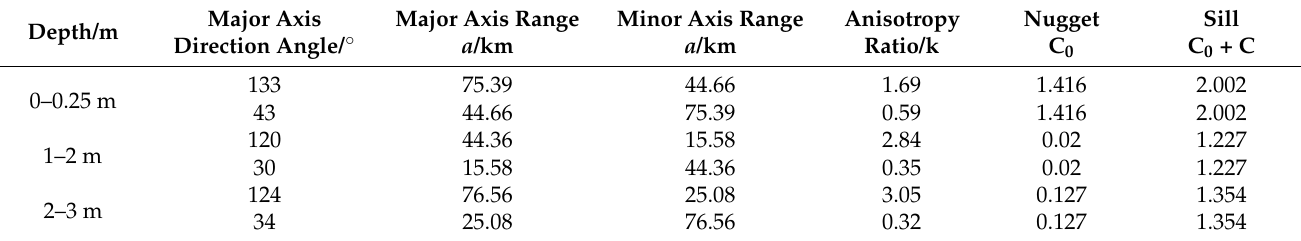
Table 4. Anisotropic parameters of soil salinity at different